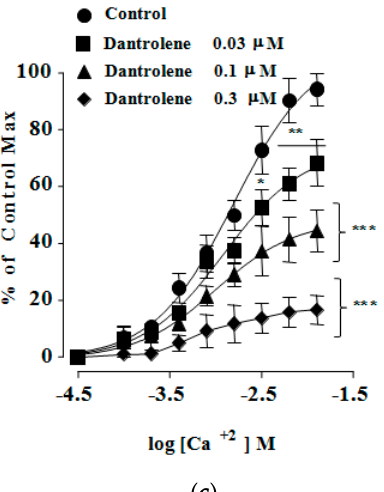
Figure 4. CRCs of Ca +2 in the absence and presence of increasing concentration of Pp.Cr (mg/mL) ( a ) verapamil (µM) ( b ) and dantrolene (µM) ( c ) on rabbit jejunum preparations. * p < 0.05, ** p < 0.01, *** p < 0.001 compared to the respective control. (Mean ± SEM, n = 3).